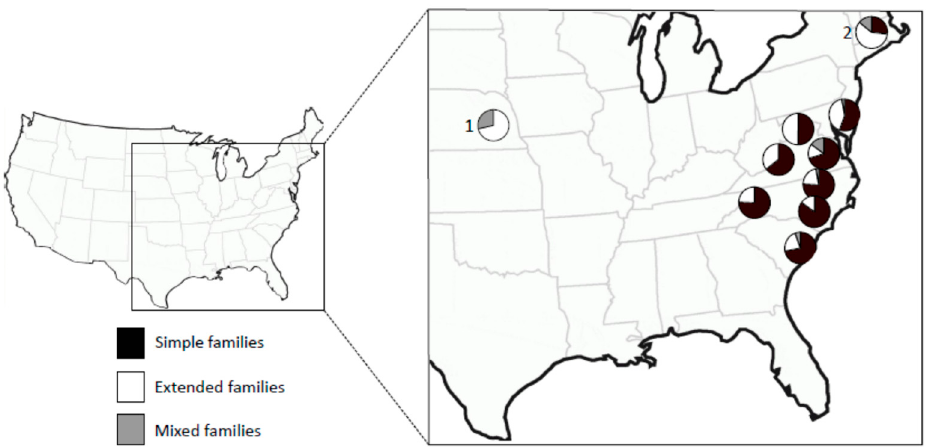
Figure 1. Variation in the breeding system in populations of Reticulitermes flavipes in the U.S. as determined by genetic markers. 1 Data from DeHeer and Kamble [22]; 2 data from Bulmer et al. [23]; all other data from Vargo et al. [24]. Sample sizes were between 7 and 314 colonies per population.